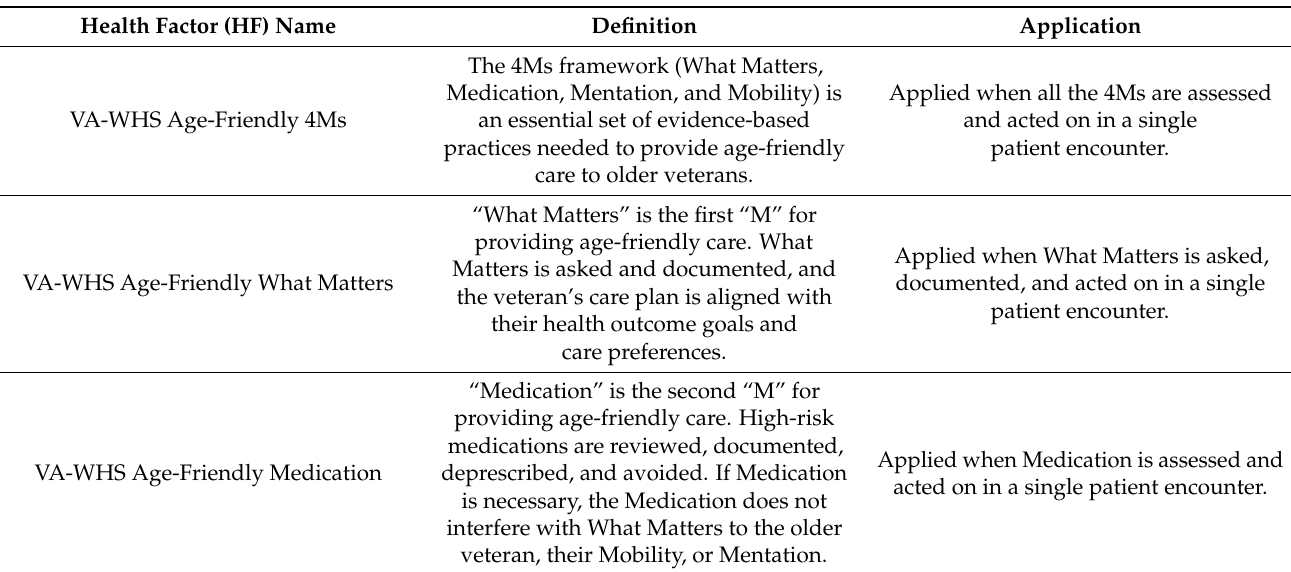
Table 1. Age-friendly whole health